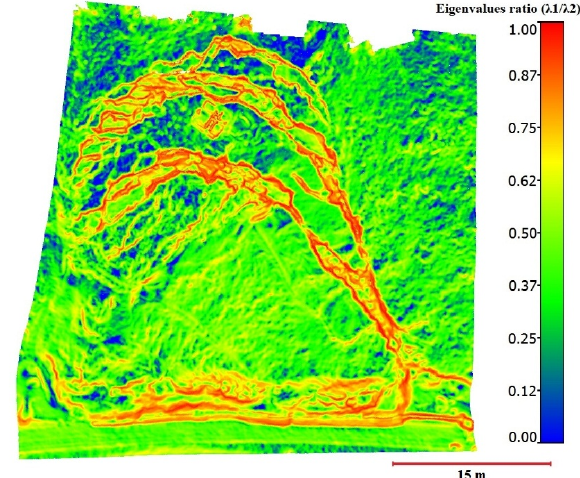
Figure 14. Eigenvalue ratio ( λ 1/ λ 2) computed with a 0.5 m moving sampling window in the dense 3D image-based point cloud. Higher Eigenvalue ratios indicate landslide scarp features because the values of these areas are less clustered than the smooth terrain surface.